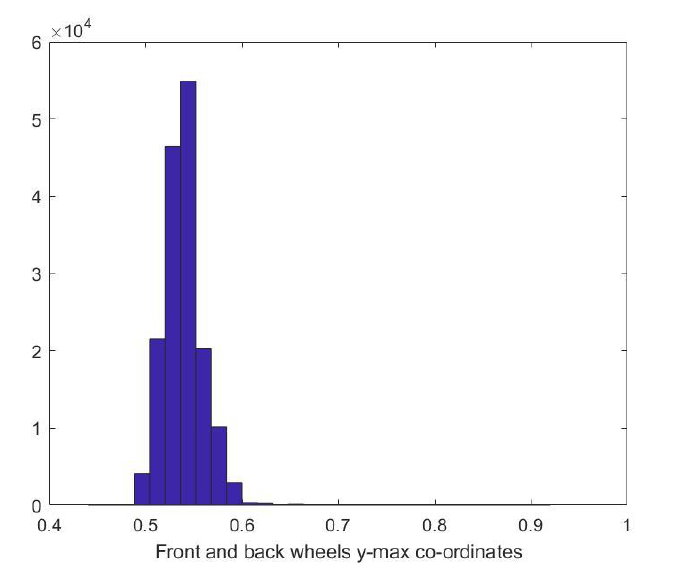
Figure 6. Wheels y-max co-ordinates